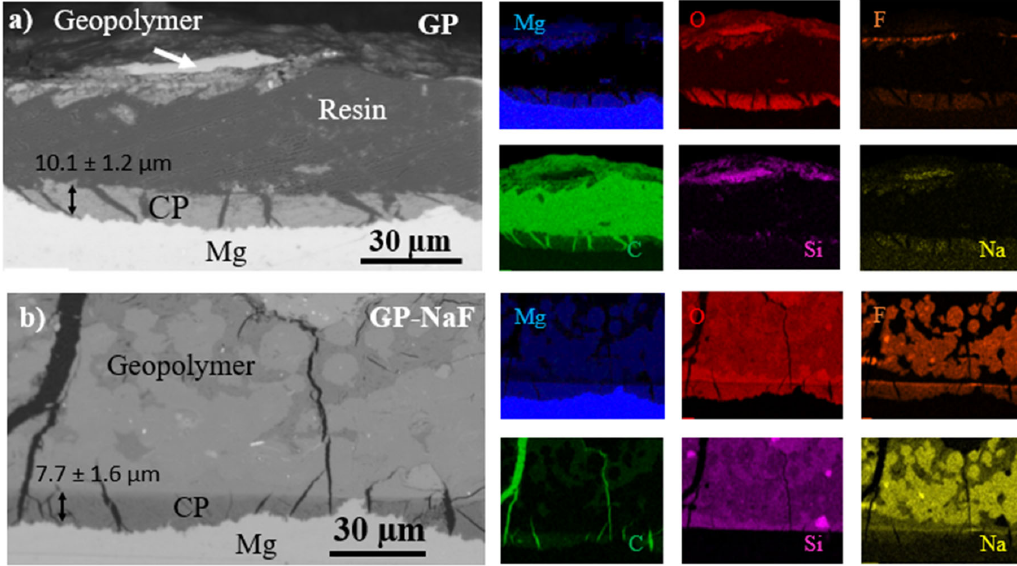
Figure 4. BSED ‐ SEM images and EDX cartographies of Mg, O, F, C, Si, and Na of ( a ) GP and ( b ) GP ‐ NaF. These results highlight the presence of cracks perpendicular to the surface of the MgZr substrate in the CP layers and geopolymers for all samples. For GP (Figure 4a), a delamination of the geopolymer from the CP film is noticeable. Indeed, during the